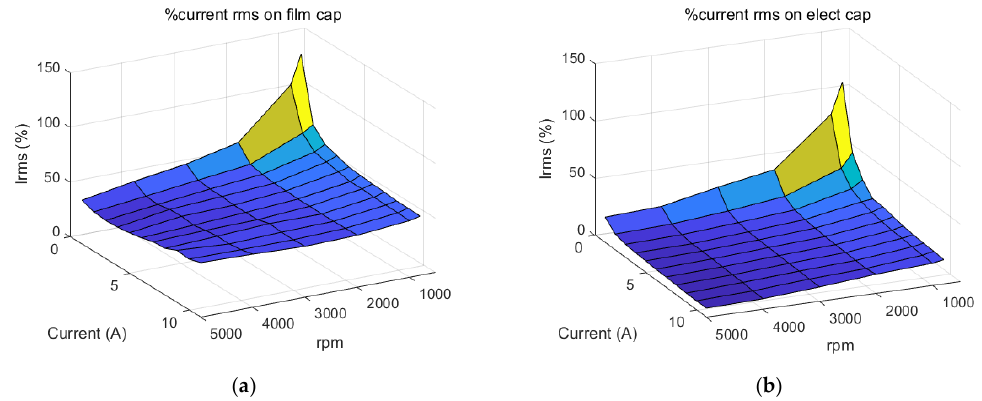
Figure 15. Percent RMS of DC-link currents of VSI with electrolytic ( a ) and film ( b ) capacitors as functions of speed and motor current.